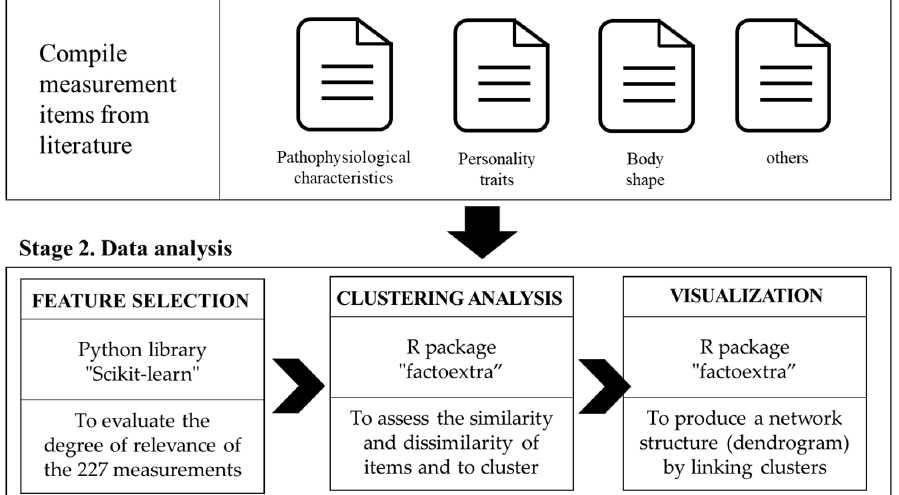
Figure 2. The procedure of the proposed method.